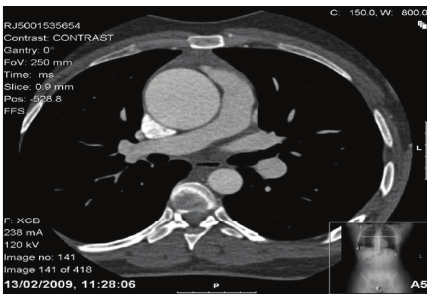
Figure 1: Contrast CT image showing large ascending aortic aneurysm measuring 6.3 × 5.4